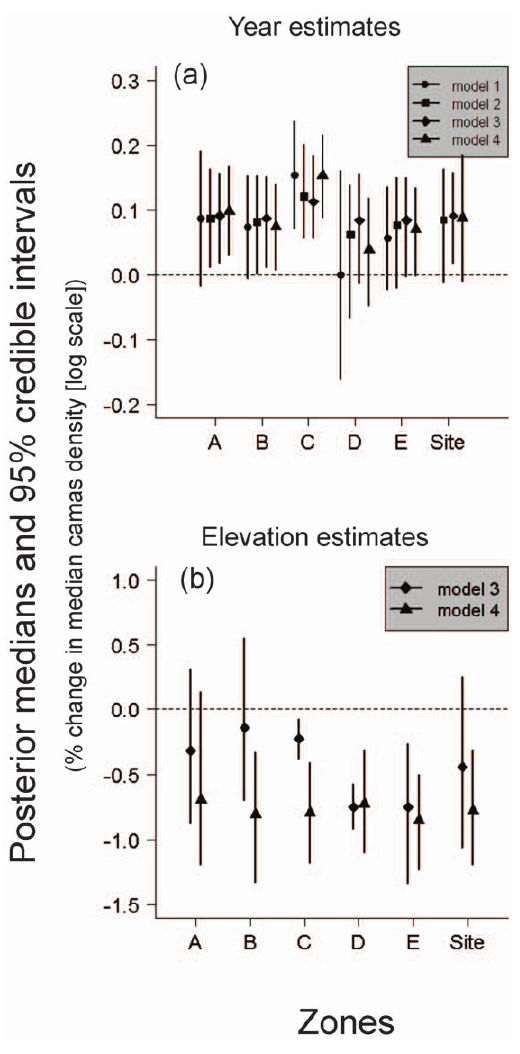
Figure 4. Posterior medians and 95% Bayesian credible intervals for a) trend and b) elevation parameters. Results are for the restoration study site from a series of 4 models of camas density each with successive amounts of spatial structure included. Model 1 represents a spatially ‘‘naı¨ve’’ approach with estimates obtained from independent simple regression models for each zone. Note that no overall restoration site estimate (i.e. m year ) is generated from model 1. Model 2 is a hierarchical model that allows for zone-specific slopes and intercepts as well as an estimate of m year for the restoration site (labeled ‘‘site’’). Model 3 is an extension of model 2 with elevation included. Model 4 adds further spatial structure by including zone-specific exponential spatial covariance models that account for residual spatial autocorrelation. 40% at 10 m lag. The CIs for j k in the restoration site were generally wide, but narrowest for zones A and D. Results for zone E indicated a complete absence of residual spatial autocorrelation